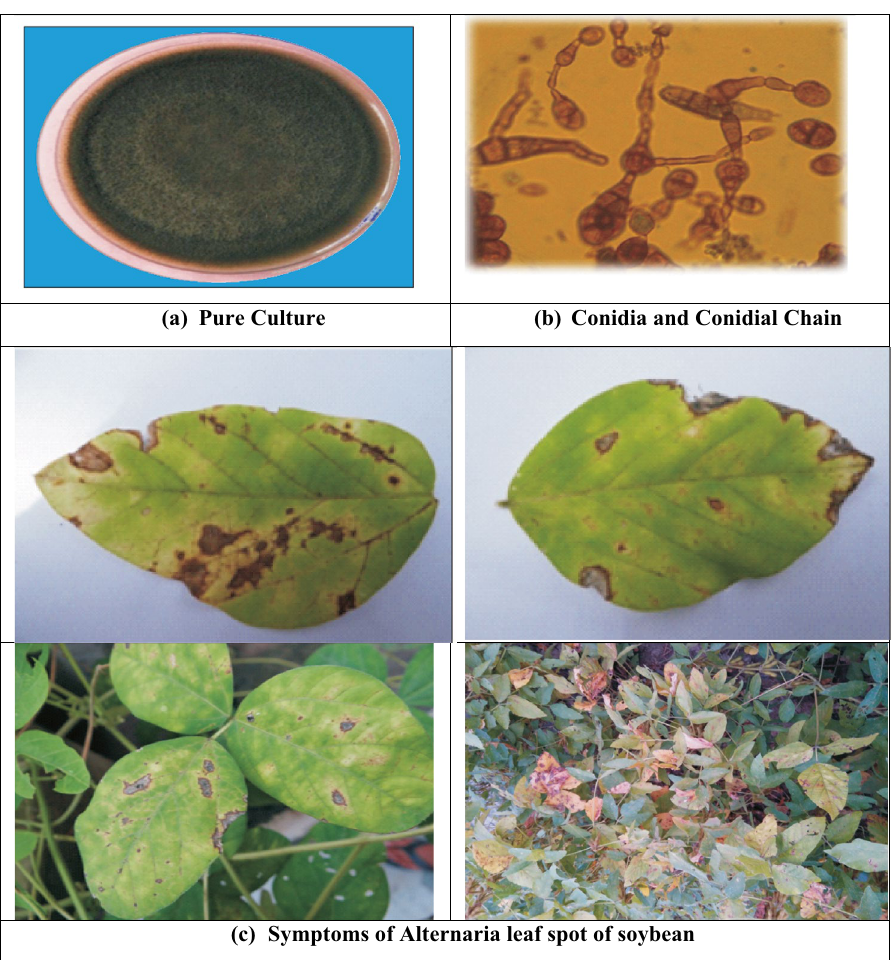
Figure 3. Characteristics and symptoms of A.